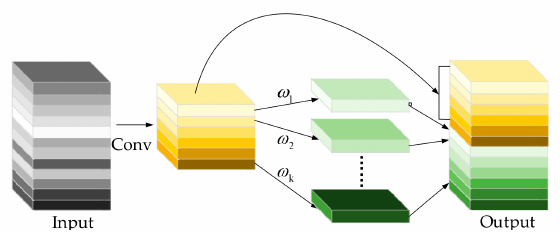
Figure 4. Schematic diagram of Ghost convolutional structure.